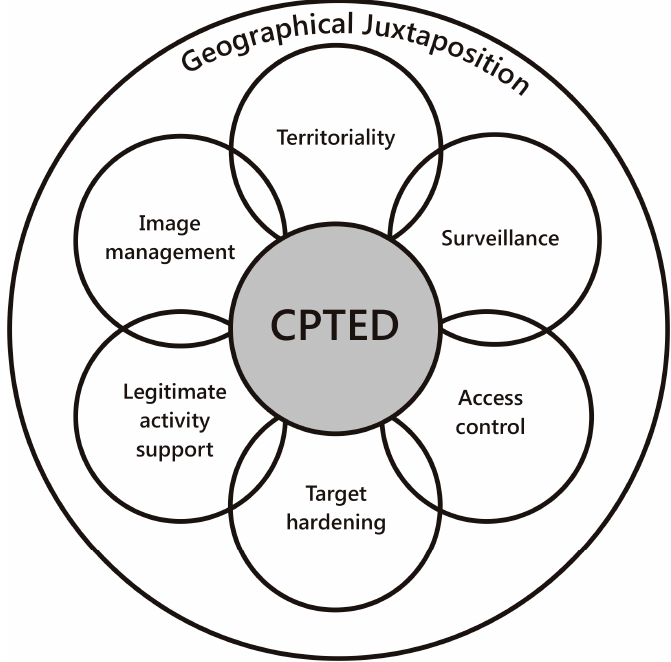
Figure 4. A Revised CPTED Model (Cozens 2016).